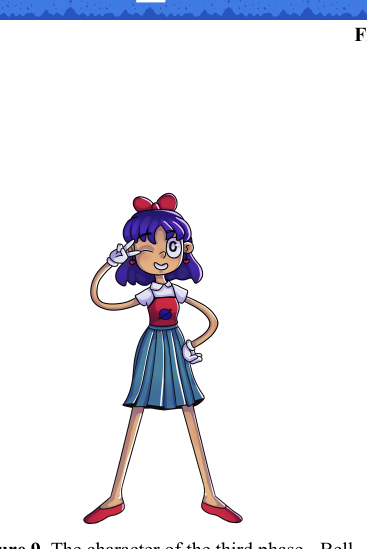
Figure 9. The character of the third phase - Bell.